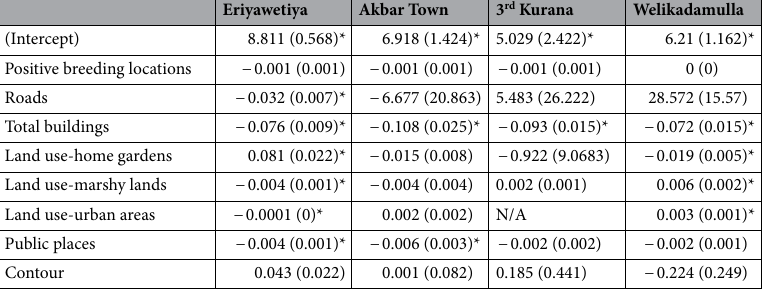
(cid:31) K —The estimates